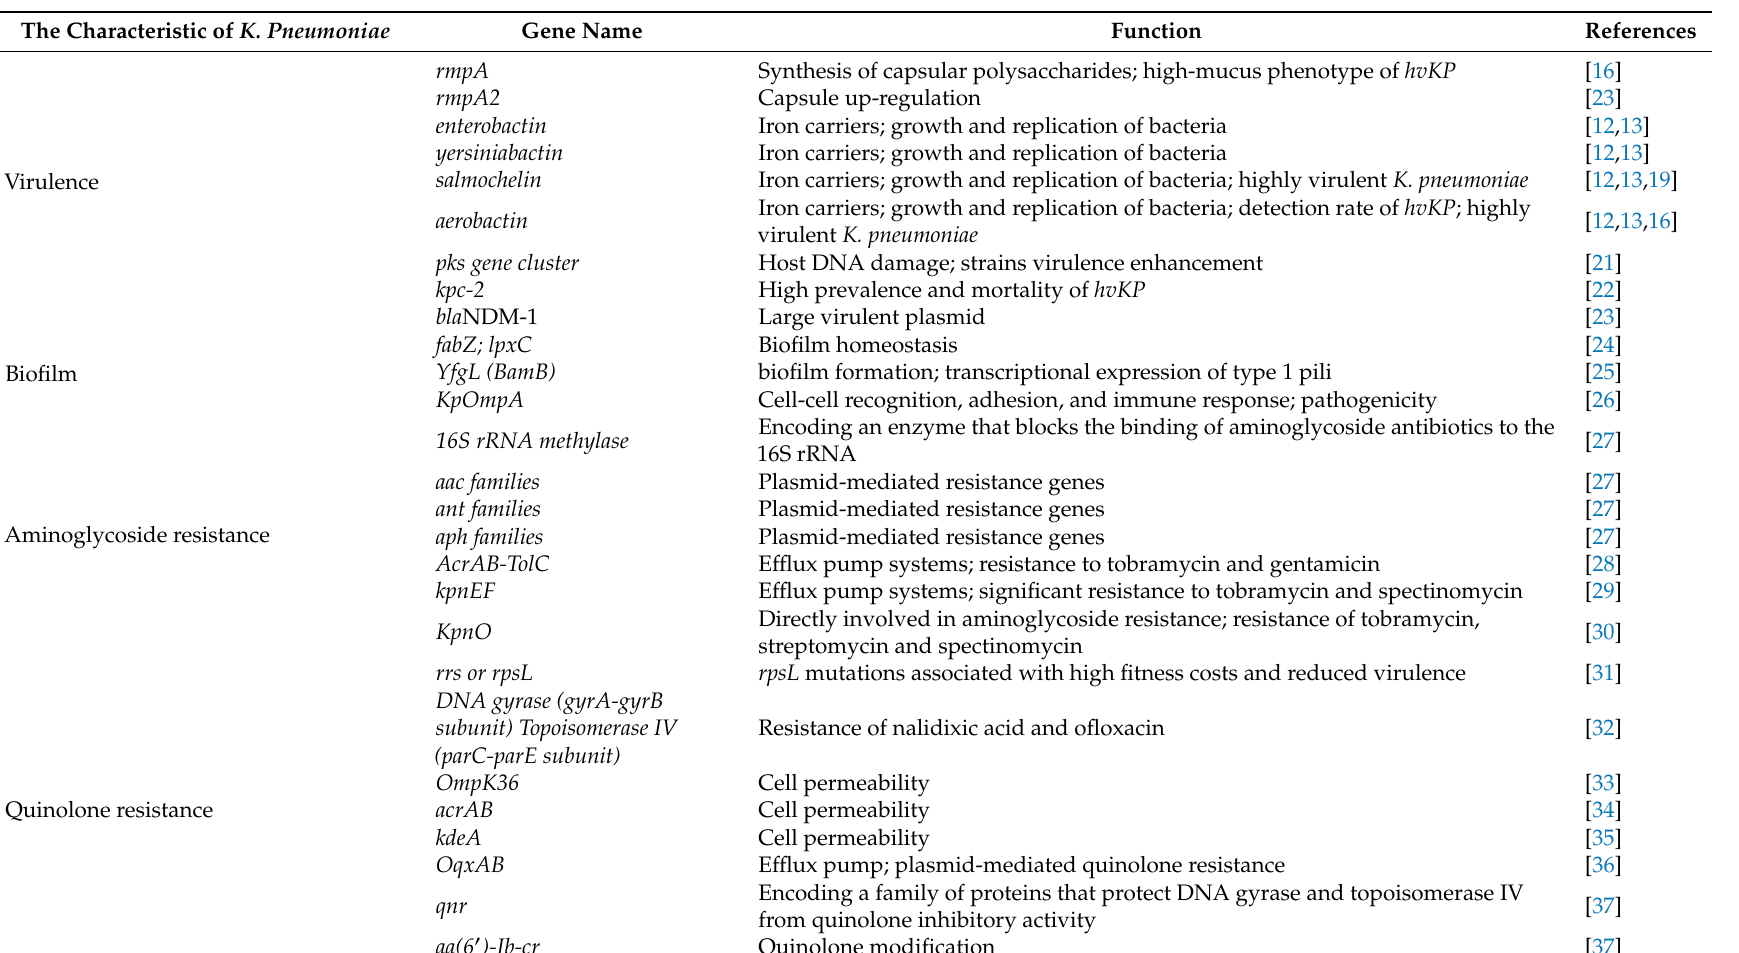
Table 1. The virulence, biofilm and antibotic resistance related genes in K. pneumoniae . The Characteristic of K.